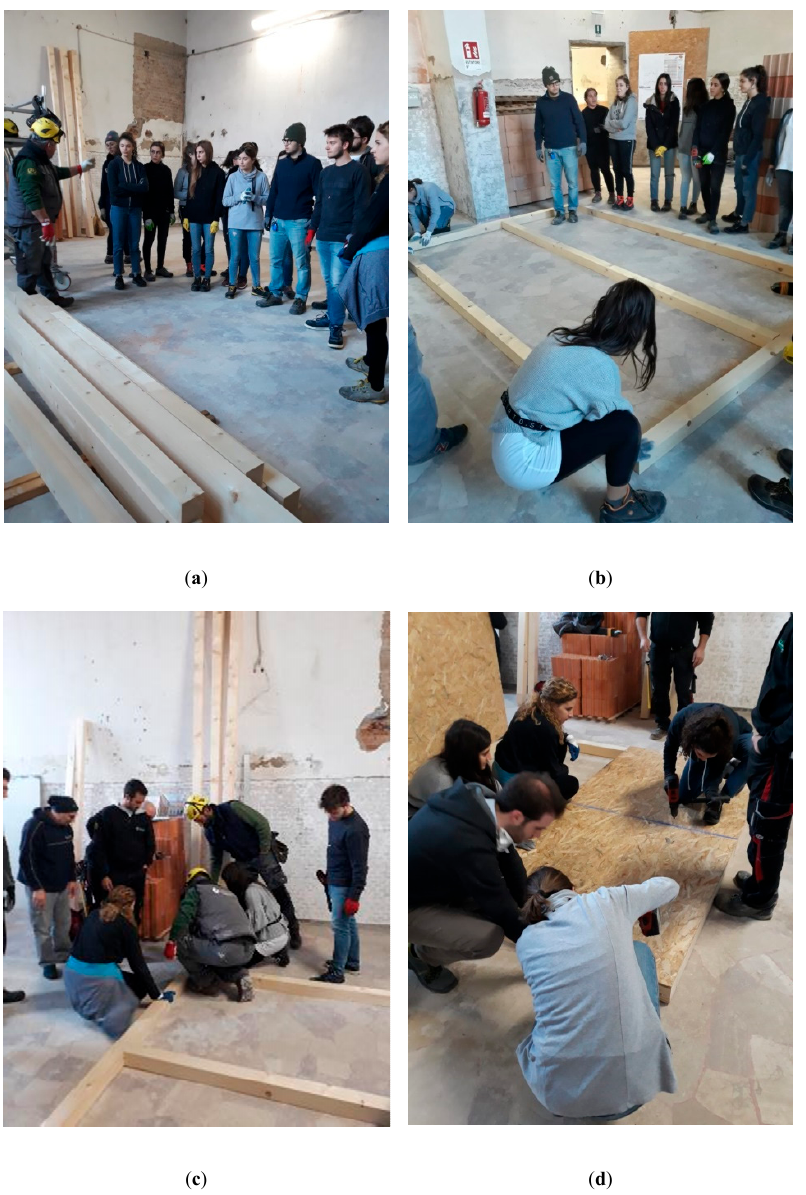
Figure A1. Box construction during SchooLab activity with students (HeLLo [32]).